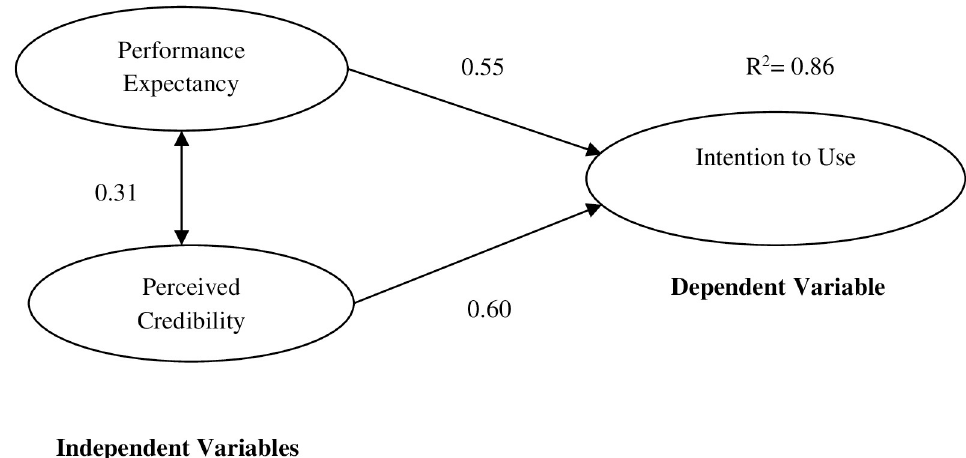
Fig 3. Structural model for female cardholders.